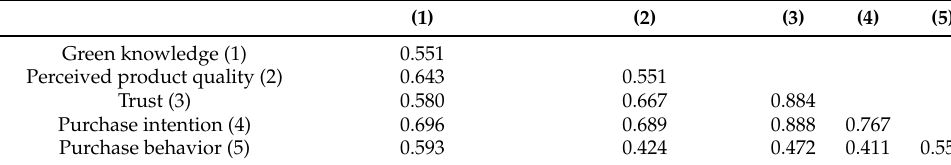
Table 6. Discriminant validity (HTMT).